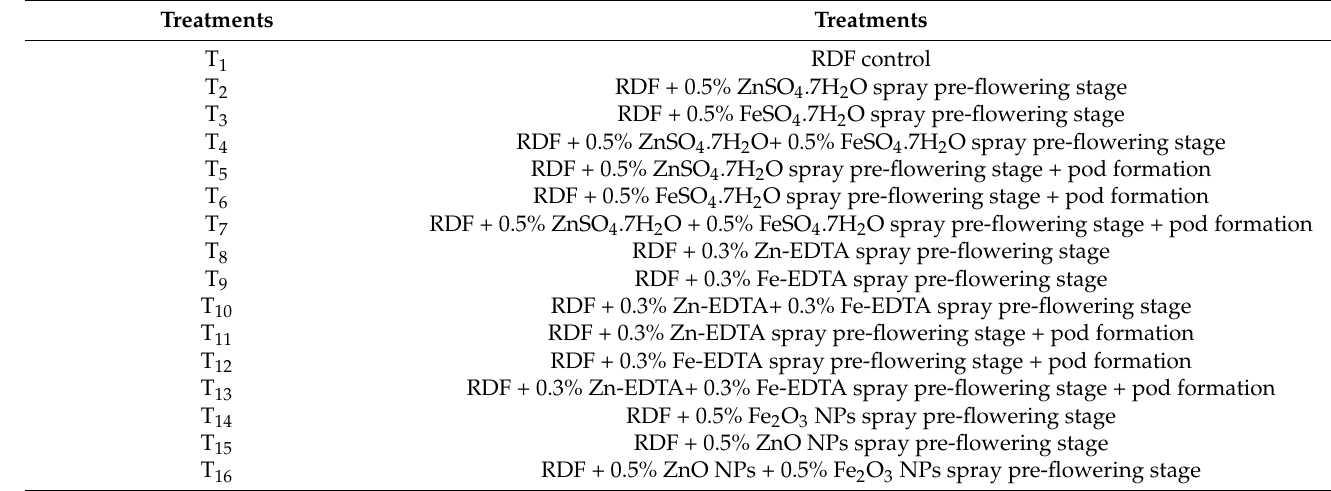
Table 1. Treatment details of the field